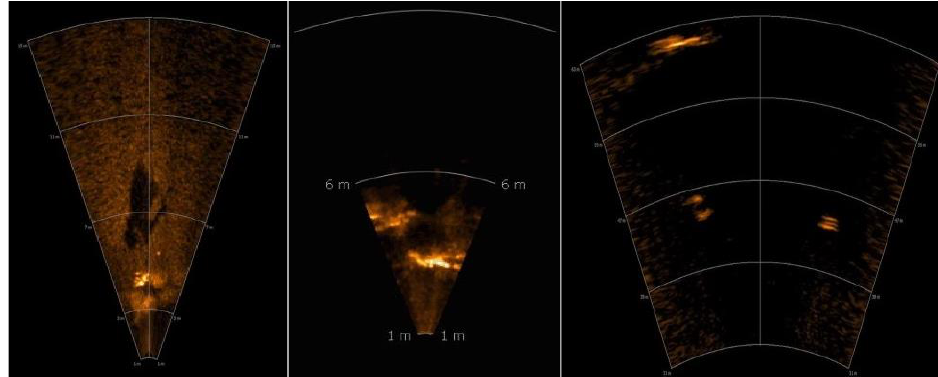
Figure 16. Examples of sonar image datasets.